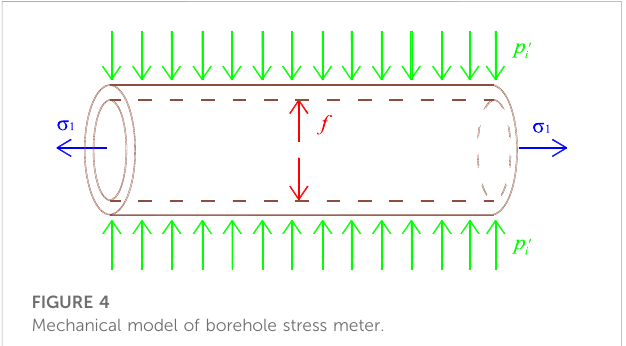
FIGURE 4 Mechanical model of borehole stress